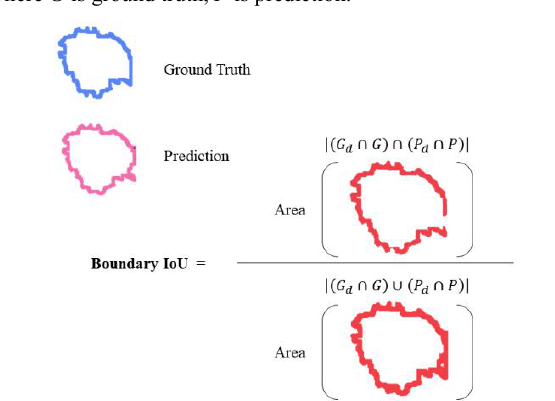
Figure 7. Boundary IoU computation